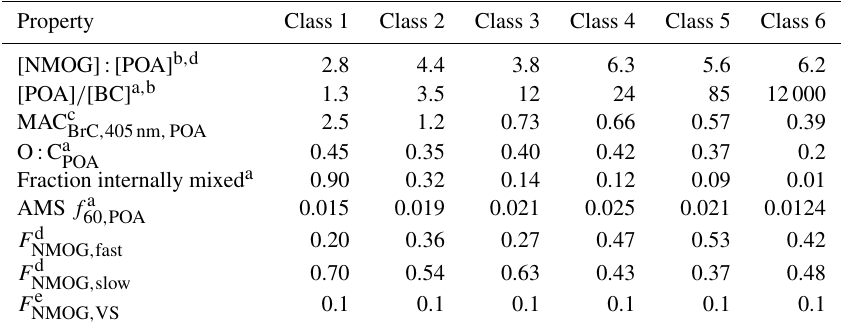
Table 2. Model parameters by particle